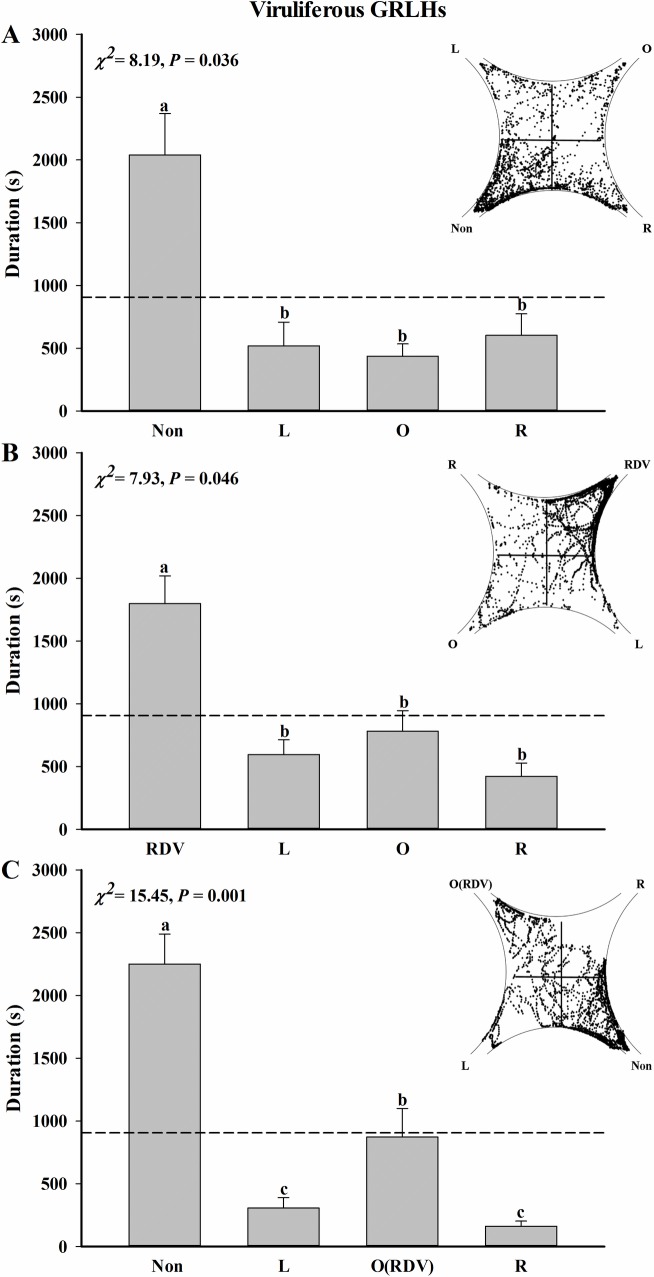
Odor selection preferences of viruliferous GRLHs exposed to rice plant volatiles.Preferences were determined as times individual insects invested in each field of a four-field olfactometer during 1 h experiments. (A) Same as Fig 3 panel A (n = 17). (B) Same as Fig 3 panel B (n = 18). (C) Same as Fig 3 panel C (n = 20). Scatter diagram show examples of location of single tracer GRLH per second during a 1 h experiment. The broken line at 900 s indicates an equal amount of time in all fields. Deviations from equal distribution were tested with a Friedman-ANOVA (P < 0.05). Bars annotated with different letters are significantly different from each other (Wilcoxon-Wilcox test).